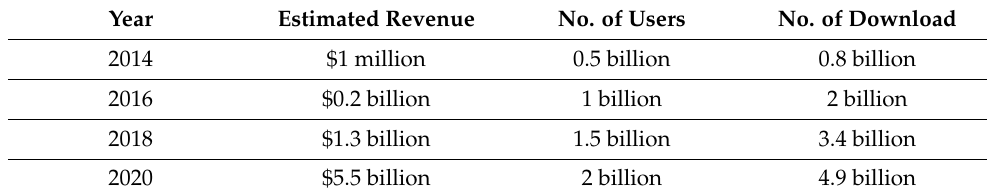
Table 1. WhatsApp revenue stats in recent years